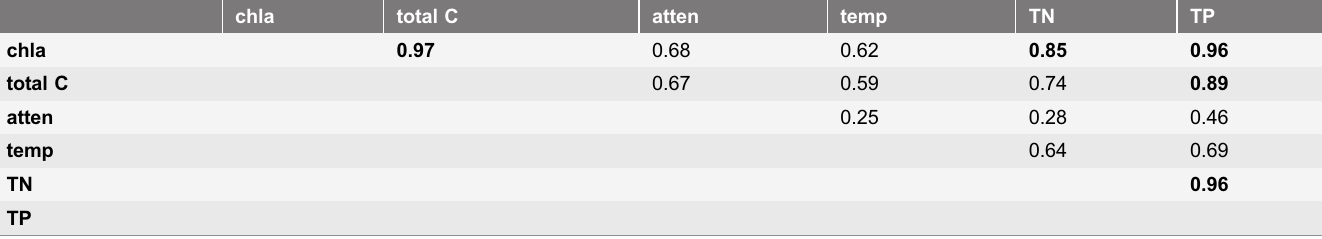
Table 2. Multiple correlations among the environmental